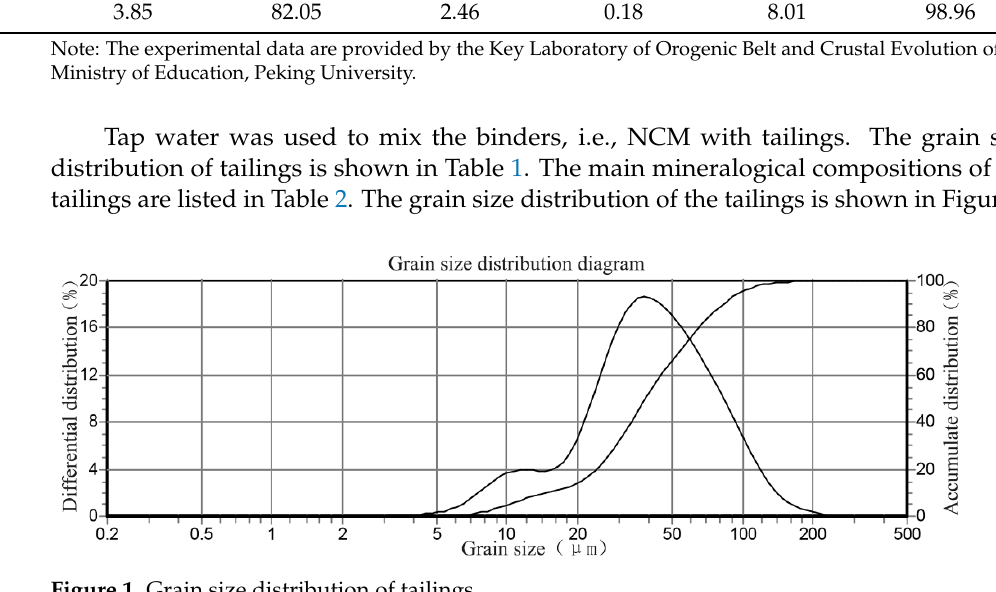
Figure 1. Grain size distribution of